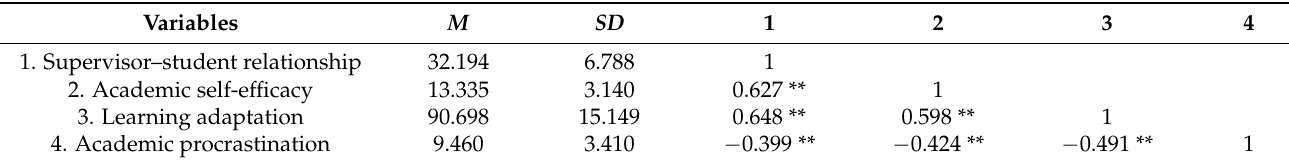
Table 1. Means, standard deviations, and correlations (N = 818).